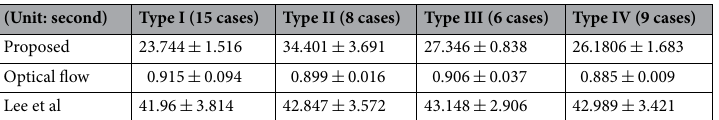
Table 5. Time performers of the proposed method in the four registration types.